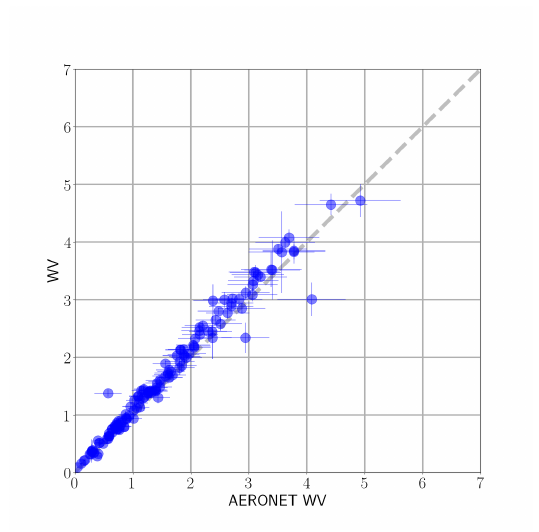
Figure 2. DESIS versus AERONET water vapor (in cm) (blue dots). The 1:1 line is represented by a grey dashed lines.